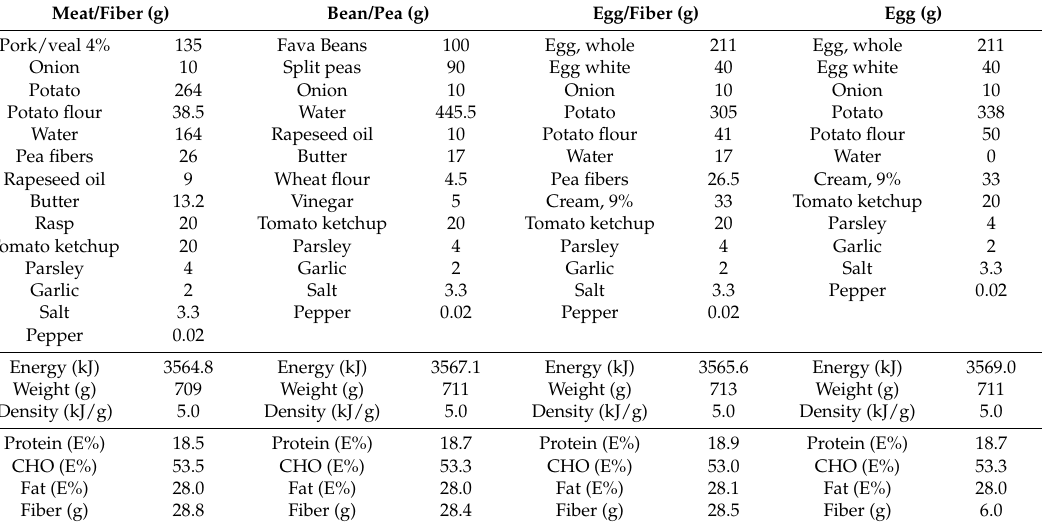
Table 2. Recipes and macronutrient composition of the four test